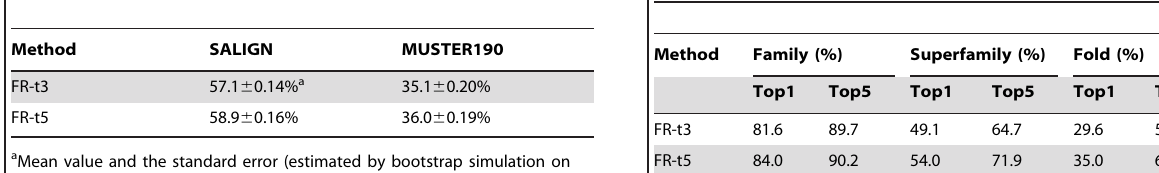
Table 1. The alignment accuracies for FR-t5 and FR-t3 on SALIGN and MUSTER190 datasets.